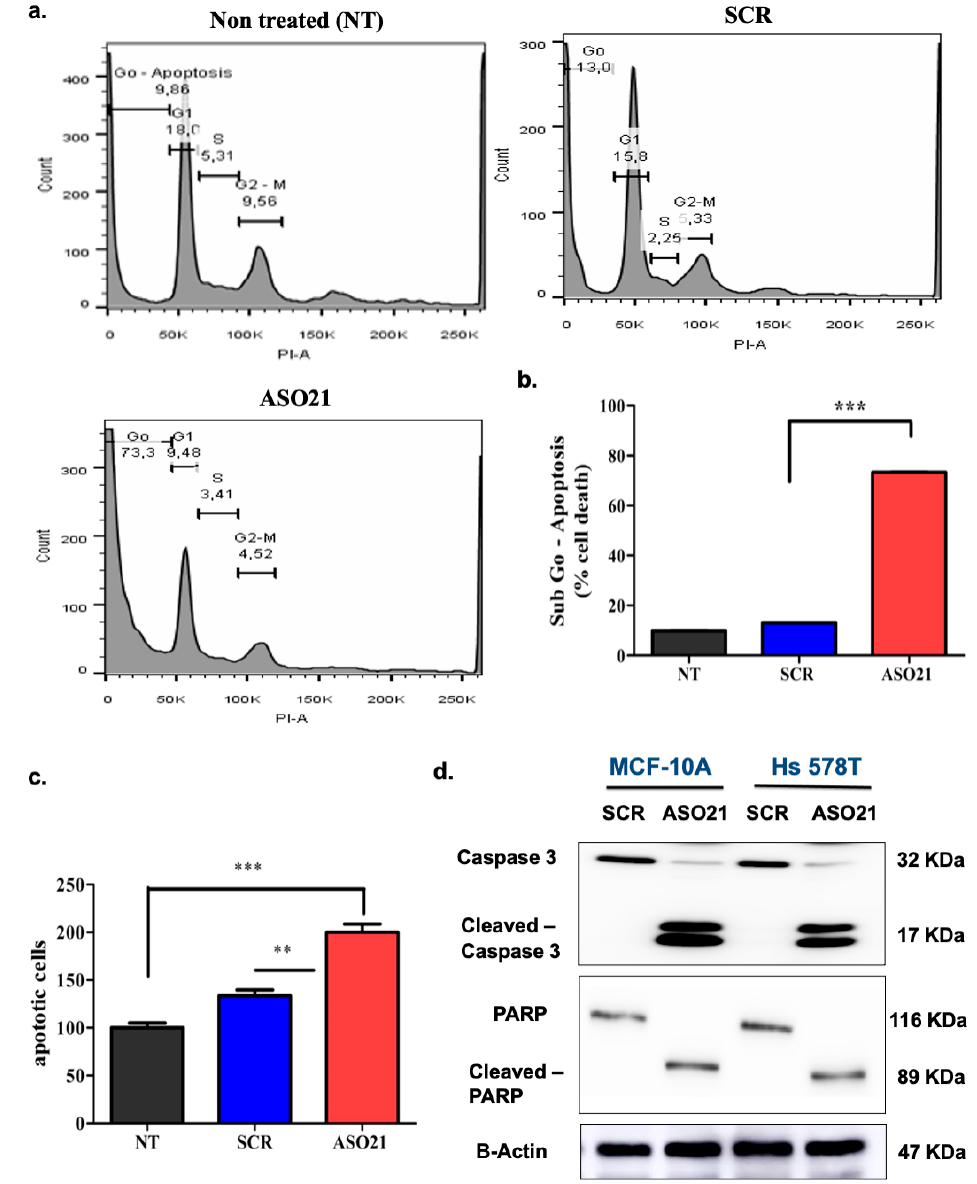
Figure 4. ASO21 induces apoptosis via the intrinsic pathway in Hs 578T cells. Hs 578T cells were treated with ASO21 and SCR at 200 nM. Three days after second transfection, cells were harvested for Western blotting analysis or for cell apoptosis and cell cycle analyses using Annexin V and pro- pidium iodide (PI). ( a ) The plots of cell cycle profiles of nontreated (NT), SCR-transfected cells (SCR) and ASO21-transfected cells (ASO21). ( b ). The graph showing the percentages of cells in sub-Go phase or death cells in NT, SCR and ASO21 samples. ASO21 caused a remarkably high proportion of death cells (73.3%) compared with NT (9.86%) and SCR (13%). ( c ) The graph displays the percent- ages of apoptotic cells in NT, SCR and ASO21 samples. ASO21 increased apoptosis in Hs 578T cells with the increased number of cells undergoing apoptosis compared with the control. ( d ) ASO 21 increased cleavage of caspase-3 and PARP in TNBC. Appearances of cleaved caspase-3 and cleaved– PARP in Hs 578T or MCF-10A treated with menin-ASO (ASO21) confirm that menin inhibition by ASO21 induces apoptosis and suggest that ASO21 can trigger the intrinsic apoptotic pathway.** p ≤ 0.01 and *** p ≤ 0.001. 3.5. Menin-ASO (ASO21) Reduces TNBC-Derived Xenograft Tumor Growth Twelve days following subcutaneous injection of Hs 578T cells, mice were treated with either ASO21 or control-ASO. At week 7, a drastic reduction in tumor growth was